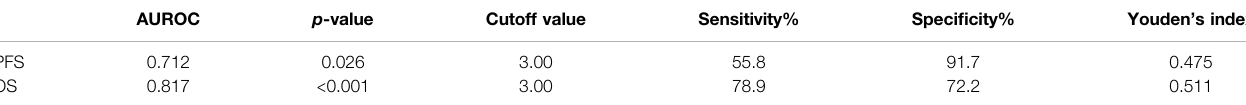
TABLE 4 | ROC curve analysis for PFS and OS in osteosarcoma with different expression scores of NLRP3 protein. AUROC